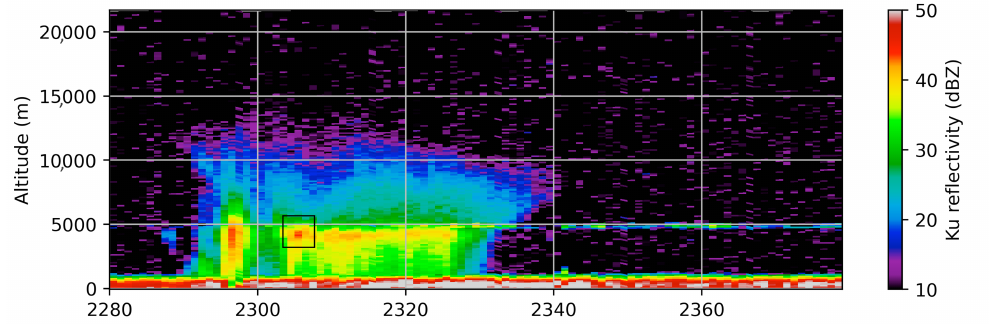
Figure 9. Cross-section along the center of the swath in Figure 8 from DPR-Ku reflectivity. The area where GB-emis and CNN/GB+emis predictions have discrepancies is highlighted by a black rectangle